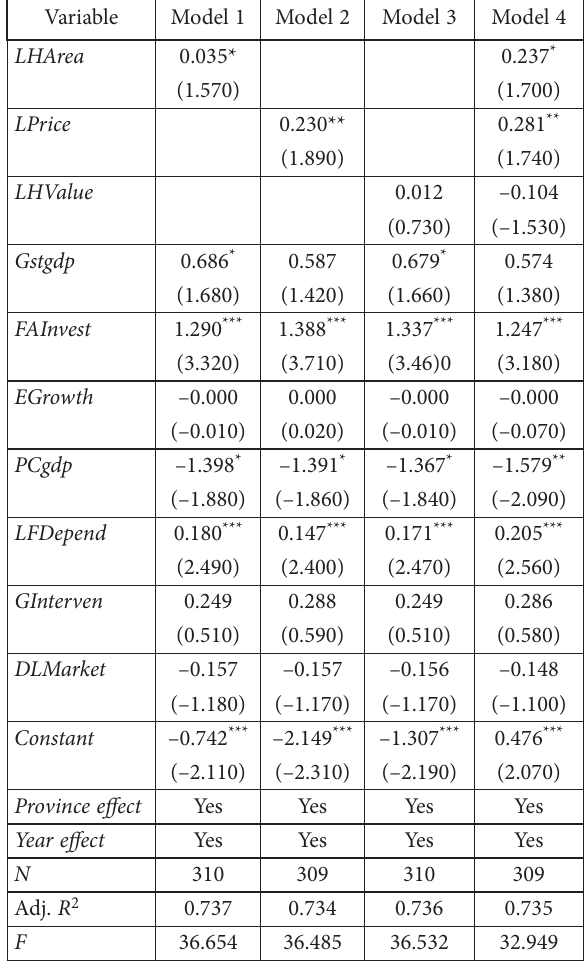
Table 4. Estimation results about UIBs’ scale